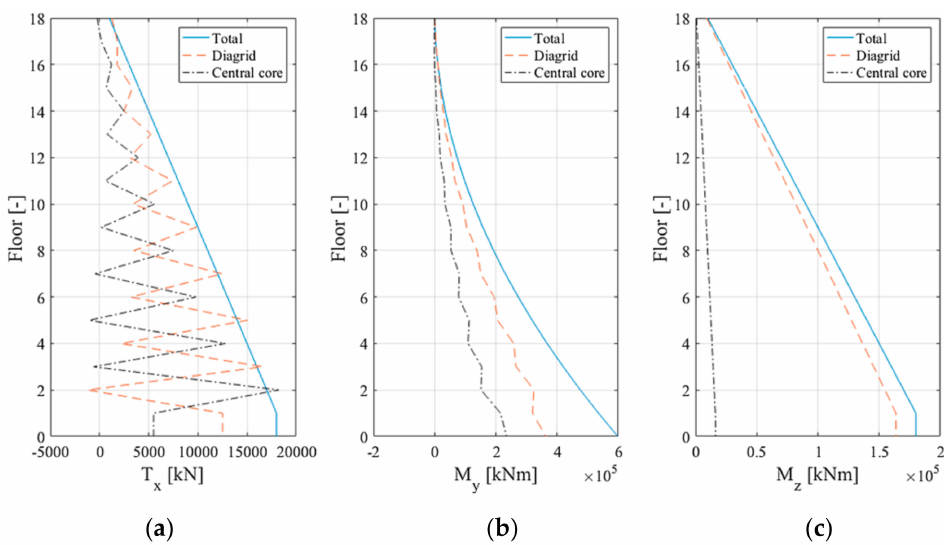
Figure 7. External steel diagrid tube coupled with a central concrete core. Distribution of: ( a ) shear forces; ( b ) bending moments; ( c ) torque moments, according to the matrix-based method (MBM) and General Algorithm (GA). Used with permission from Lacidogna et al.